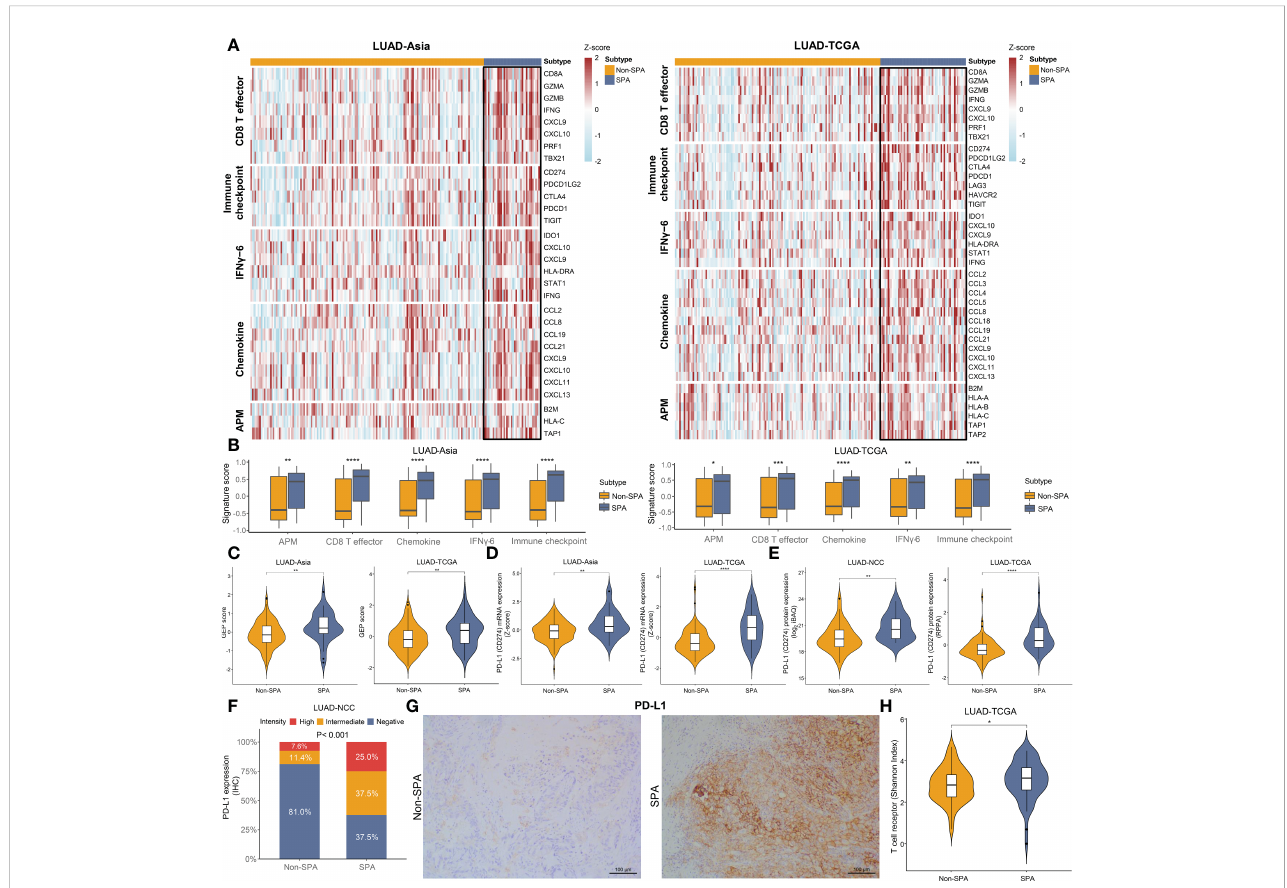
FIGURE 5 Immunity markers in SPA and Non-SPA. (A) Heatmaps of gene signatures associated with response to immunotherapy in LUAD-Asia and LUAD-TCGA. (B) Comparison of signature scores of the selected signatures between SPA and Non-SPA. (C) T cell-in fl amed GEP scores in SPA and Non-SPA. (D, E) Comparison of mRNA expression and protein abundance of PD-L1 between SPA and Non-SPA. (F) Comparison of PD-L1 expression determined by immunohistochemistry between SPA and Non-SPA in LUAD-NCC. (G) Representative images of PD-L1 immunostaining in SPA and Non-SPA form LUAD- NCC. (H) Comparison of T cell receptor diversity between SPA and Non-SPA in LUAD-TCGA. SPA, solid predominant adenocarcinoma; Non-SPA, nonsolid predominant adenocarcinoma; CD8 T effector, effector CD8 T cell signature; IFN g -6, six-gene IFN g signature; APM, antigen presenting machinery; GEP, gene expression pro fi le; RPPA, reverse phase protein array; IHC, immunohistochemistry. ****P < 0.0001, ***P < 0.001, **P < 0.01, *P <